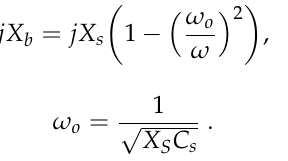
Standard Brune Section. ( c ) Coupled Inductor representation of the Brune Section. Brune Section. ( c ) Coupled Inductor representation of the Brune